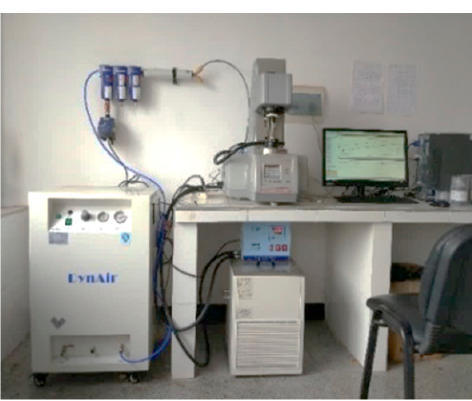
Figure 2. The employed rheometer.